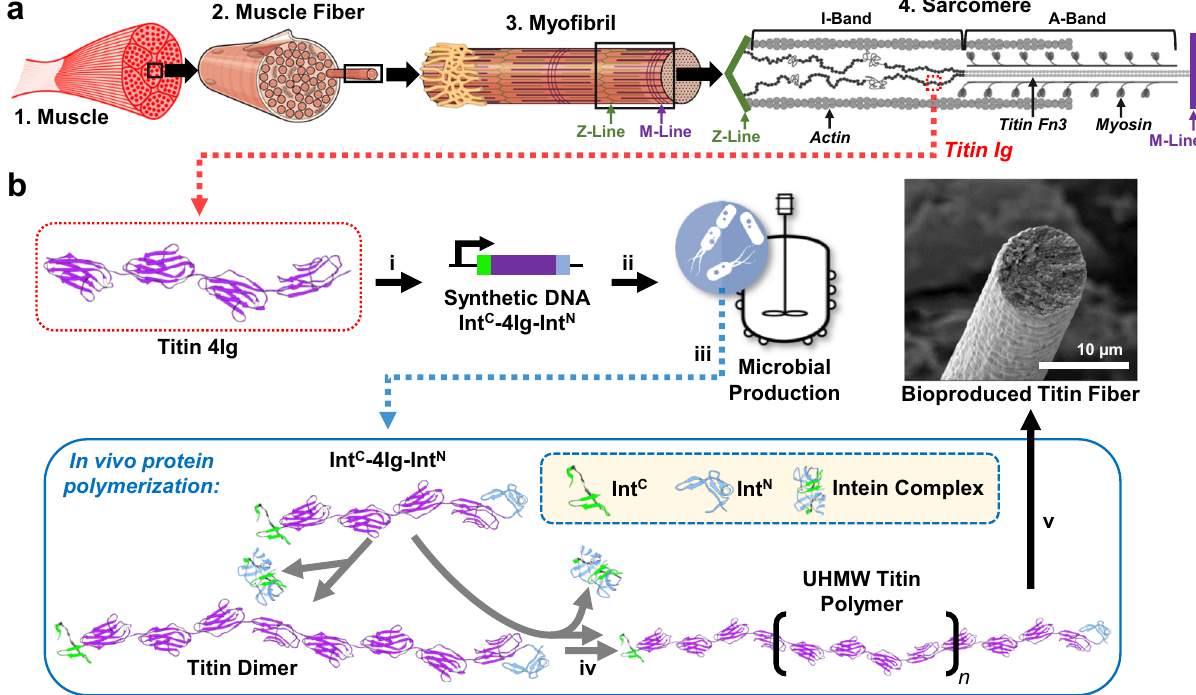
Fig. 1 The multi-scale structure of muscle and schematic representation of SI-based polymerization of the titin protein in E. coli . a Muscle tissue (1) is composed of specialized, elongated (>1cm) cells called muscle fi bers (2). Muscle fi bers are packed with proteinaceous myo fi brils (3) that span the entire length of the cell. Myo fi brils are composed of repeating stacks of chemically controllable, contractile elements called sarcomeres. (4) Sarcomeres are composed primarily of three proteins: actin, myosin, and titin. Titin spans half the length of the sarcomere, anchoring the opposing Z- and M-lines, and consists of hundreds of repeating immunoglobulin (Ig) domains that are integral to the passive strength (i.e., resistance to deformation without energy input), damping capacity, and mechanical recovery of the macroscopic muscle fi ber. The images of muscle fi ber and myo fi bril are modi fi ed from the OpenStax Anatomy and Physiology Textbook Version 8.25, Published May 18, 2016 (OpenStax, CC BY 4.0 https://creativecommons.org/licenses/by/4.0) and the image of the sarcomere is modi fi ed from Giganti, D., Yan, K., Badilla, C.L. et al. Disul fi de isomerization reactions in titin immunoglobulin domains enable a mode of protein elasticity. Nat Commun 9, 185 (2018). 10.1038/s41467-017-02528-7, (David Giganti, Kevin Yan, Carmen L. Badilla, Julio M. Fernandez & Jorge Alegre-Cebollada, CC BY 4.0 https://creativecommons.org/licenses/by/4.0). b To facilitate the production of UHMW titin polymer in vivo, a relatively small, genetically stable, 41.3 kDa rabbit soleus titin protein-coding sequence (4 Ig; purple) was fl anked by complimentary SIs, gp41-1 C (Int C ; green) and gp41-1 N (Int N ; blue) (i). DNA sequence-recoded Int C -4Ig-Int N was produced in an engineered E. coli host under the control of inducible promoter P LacO-1 (ii). The SI- fl anked monomer protein was overexpressed in bioreactor cultures (iii) and polymerized intracellularly through successive rounds of SI-catalyzed intermolecular ligation to produce UHMW titin (iv). Puri fi cation and processing yielded microbially produced titin fi bers that recapture the damping capacity and mechanical recovery of muscle along with high strength and toughness (v). Titin 4 Ig and SI structures were acquired using PBD accession numbers 3B43 and 6QAZ,